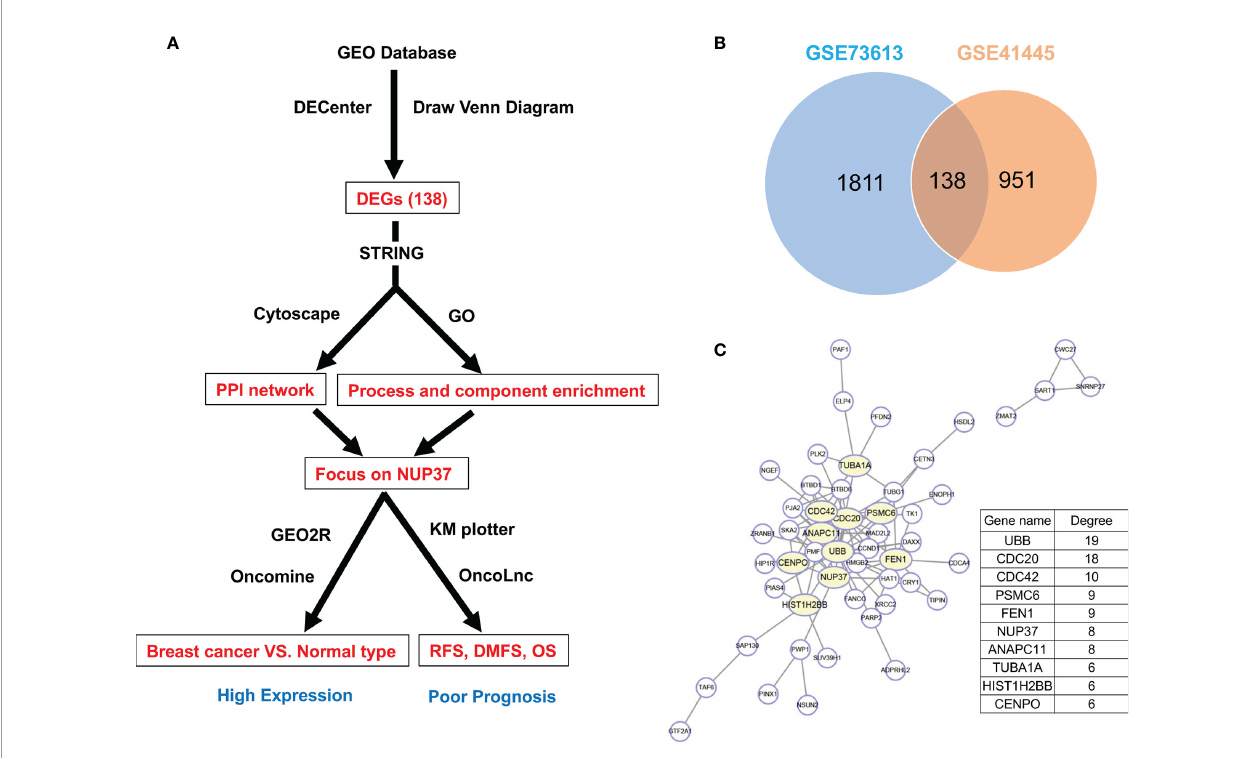
FIGURE 1 | Gene screening and identi fi cation of the hub gene. (A) Illustrates the screening process of key gene in a simpli fi ed sequence fl ow diagram. (B) Identi fi cation of up-regulated DEGs in BRCA compared with normal control samples from GEO datasets (GSE73613, GSE41445). (C) PPI networks map of upregulated DEGs. The top 10 node genes with higher degrees are labeled in yellow, and the degree of the top 10 node genes are